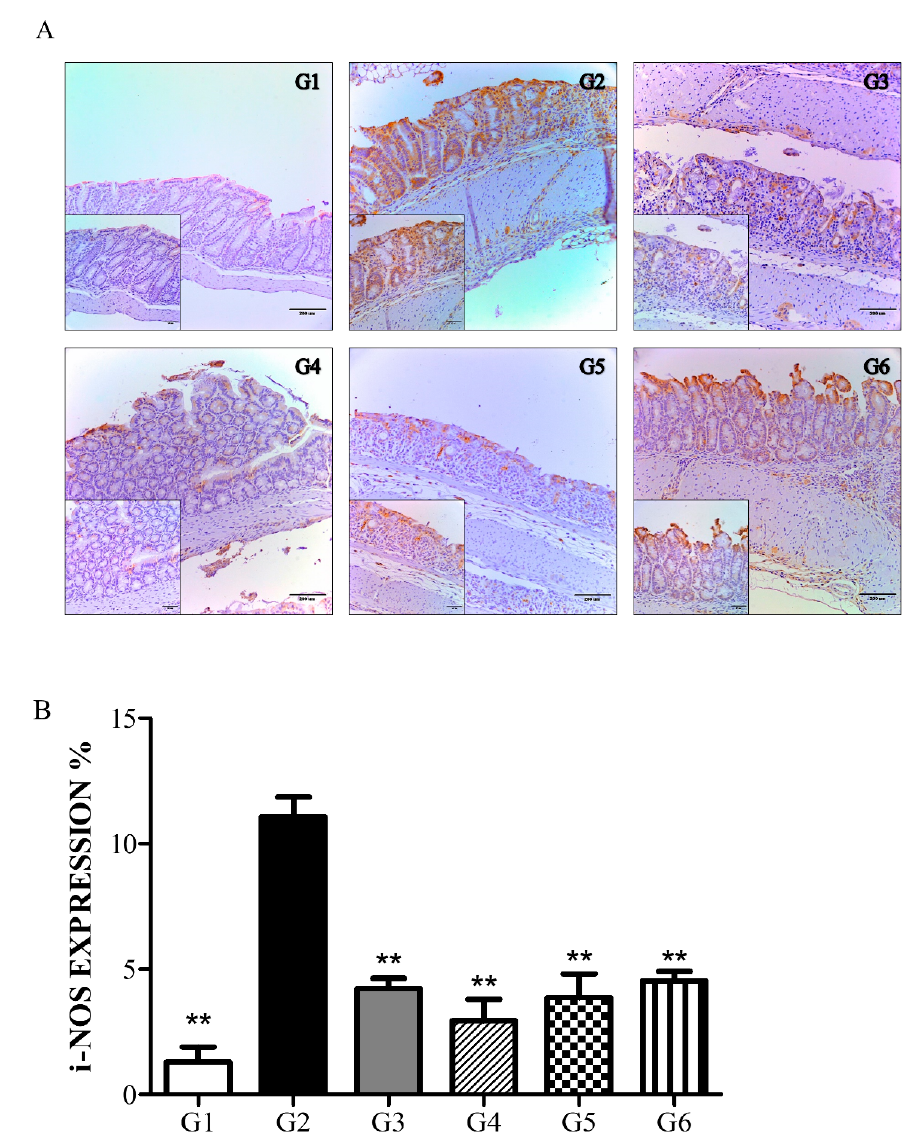
Figure 6. Result of immunohistochemical analysis: effect of phytoncide treatment on iNOS expression in DSS-induced colitis damage. ( A ) Photograph of colon from mouse with DSS-induced colitis, × 100 magnification. ( B ) iNOS expression graph of mouse with DSS-induced colitis. G1, normal control; G2, vehicle control (colitis control, DSS 2% in DW); G3, prevention phytoncide oil 10 mL/kg; G4, therapy phytoncide oil 10 mL/kg; G5, prevention pine cone water extract 10 mL/kg; G6, therapy pine cone water extract 10 mL/kg. ** p < 0.01 compared to vehicle control.